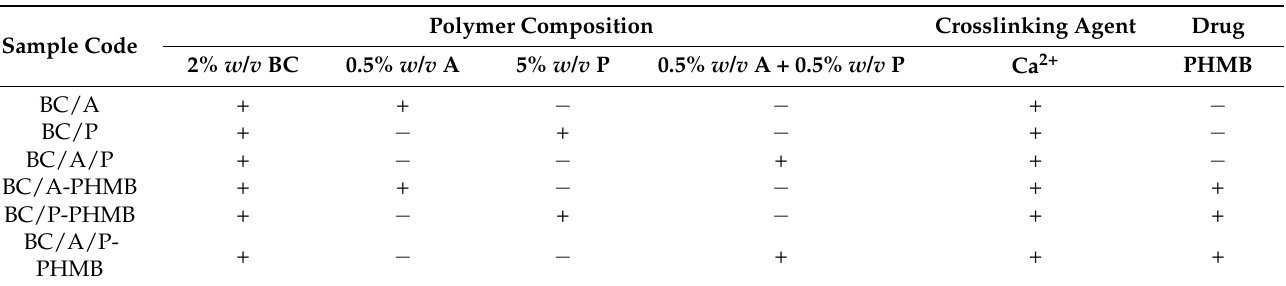
Table 1. Composition of different hydrogels containing